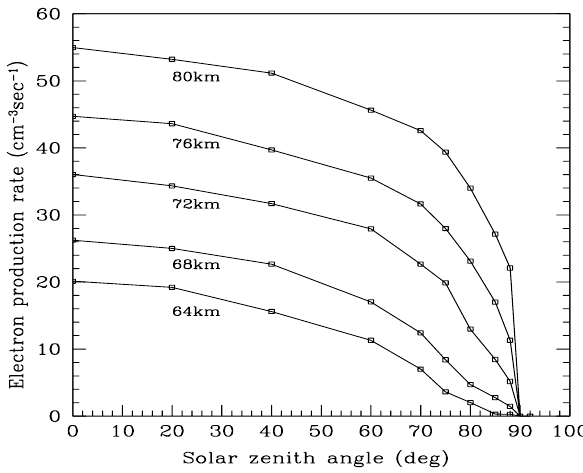
Fig. 4. Variation of electron production rates with the angular position of the Sun at different heights assuming an M-class spectrum.